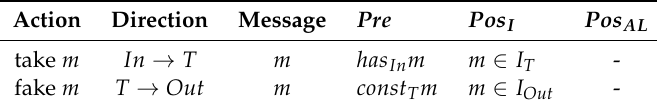
Table 1. Action model of the